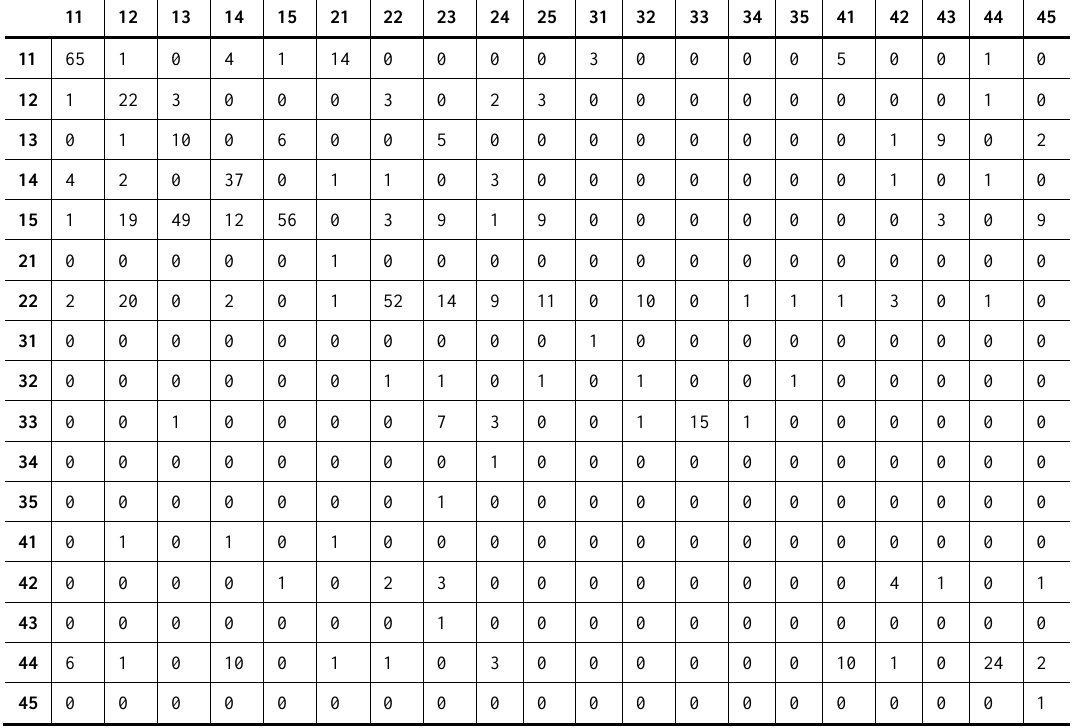
Table 3 .Error matrix of the land-cover transitions of the objects by pcc